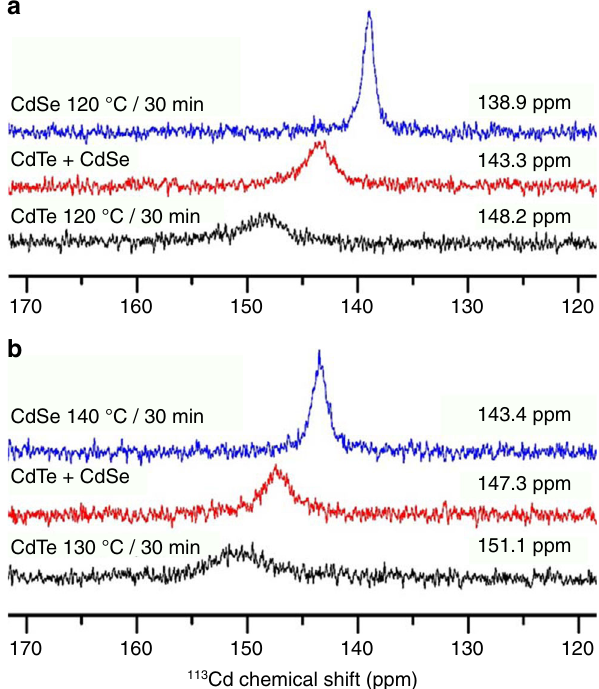
Fig. 4 113 Cd NMR spectra of two sets of binary samples and their mixtures. a Both binary samples for CdTe (black trace) and CdSe (blue trace) were reacted at 120 °C for 30 min, and the mixture (red trace) was obtained by mixing the two binary samples with equal volumes at room temperature for 15 min incubation. b CdTe (black trace) and CdSe (blue trace) samples were reacted for 30 min at 130 and 140 °C, respectively, and their mixture (red trace) was obtained with equal volumes at room temperature for 15 min incubation. The binary samples were prepared as indicated. The 113 Cd resonance signals of the two mixtures (red traces), locating between those from the binary samples, are in agreement with the substitution reactions described by Equations (2) and